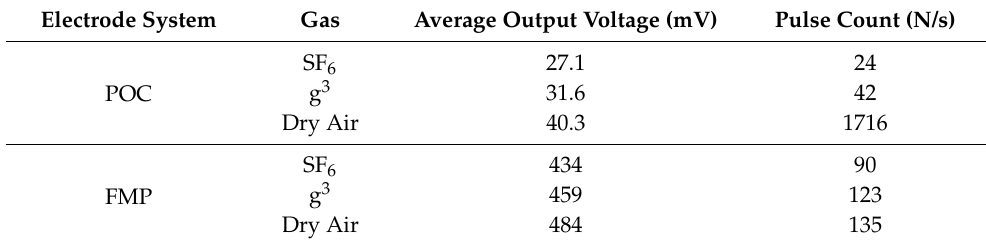
Figure 7. Phase-resolved partial discharge (PRPD) patterns: ( a ) in POC and ( b ) in FMP. Table 2. Average output voltage and pulse count.